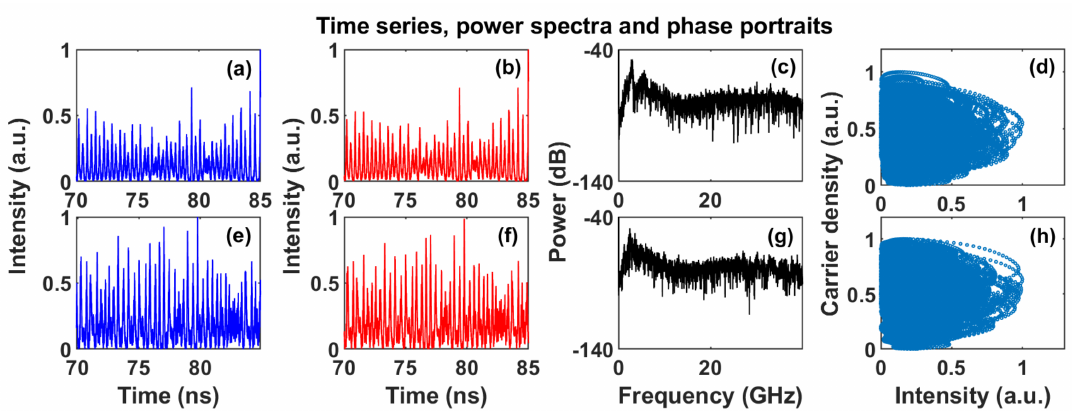
Figure 2. Time series of ( a , e ) the first channel and ( b , f ) the second channel of TLs and RLs. ( c , g ) Power spectra of TLs. ( d , h ) Phase portraits of TLs.